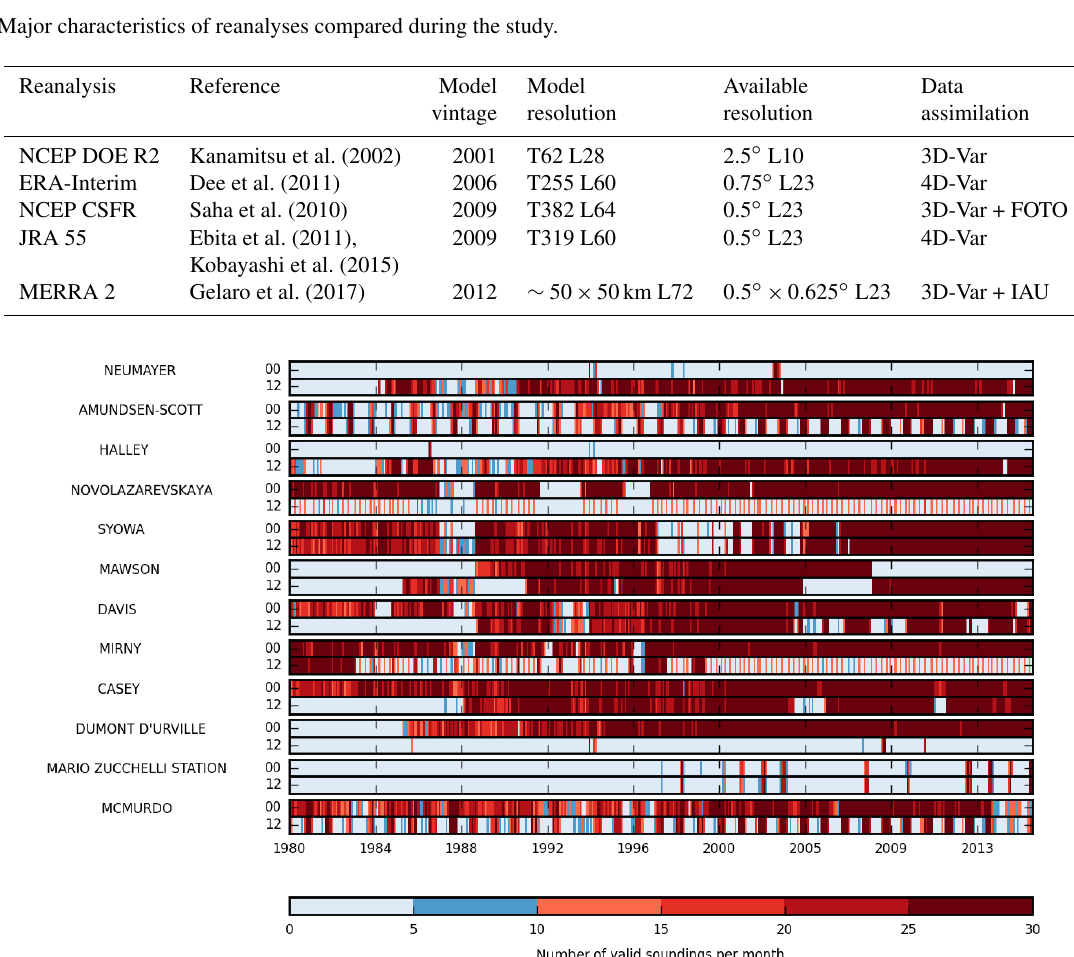
Figure 2. Monthly density of valid humidity and wind soundings per station and per synoptic time (midnight and noon